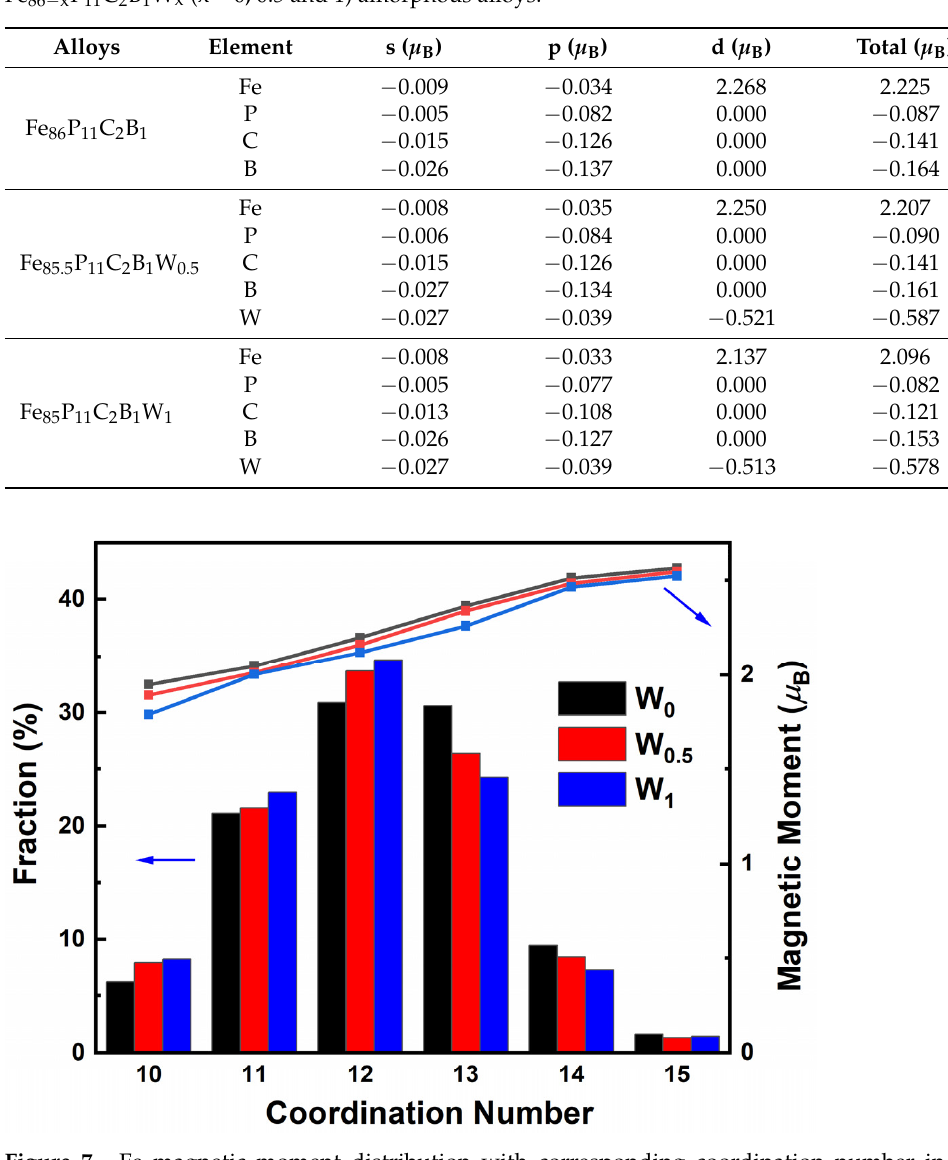
Table 3. Average magnetic moments of each atomic orbital for the Fe, P, C, B, and W atoms in the